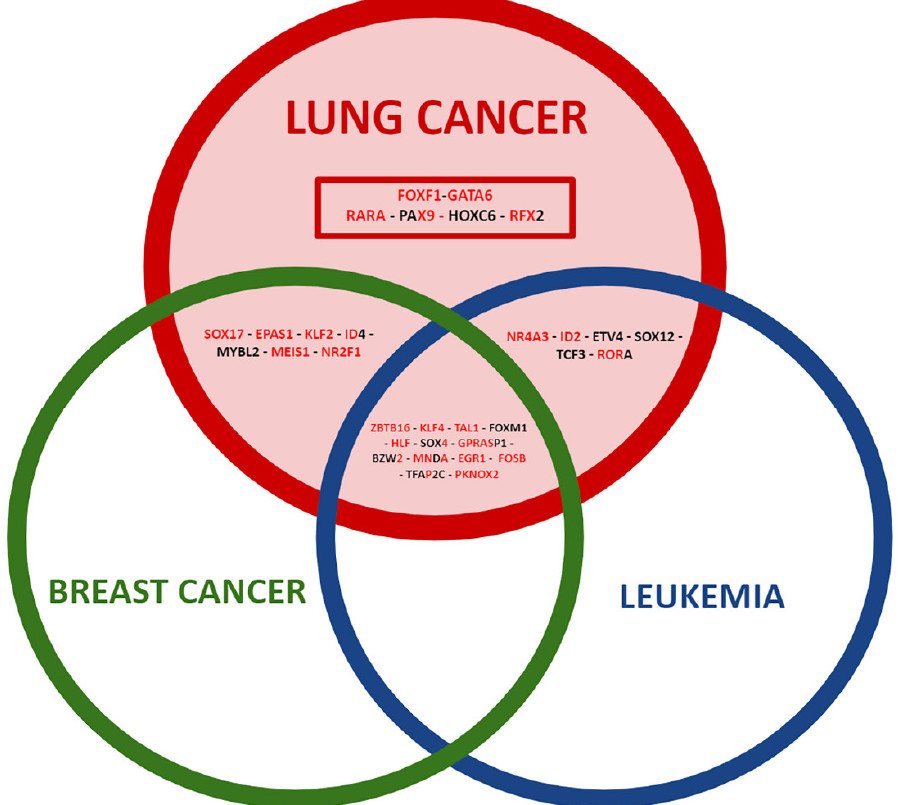
Figure 12. Venn diagram with the transcriptomic metafirm of winning and coexpressed transcription factors common among the three types of cancer and unique to lung cancer. Negatively regulated transcription factors are in bold red, and positively regulated transcription factors are in bold black.